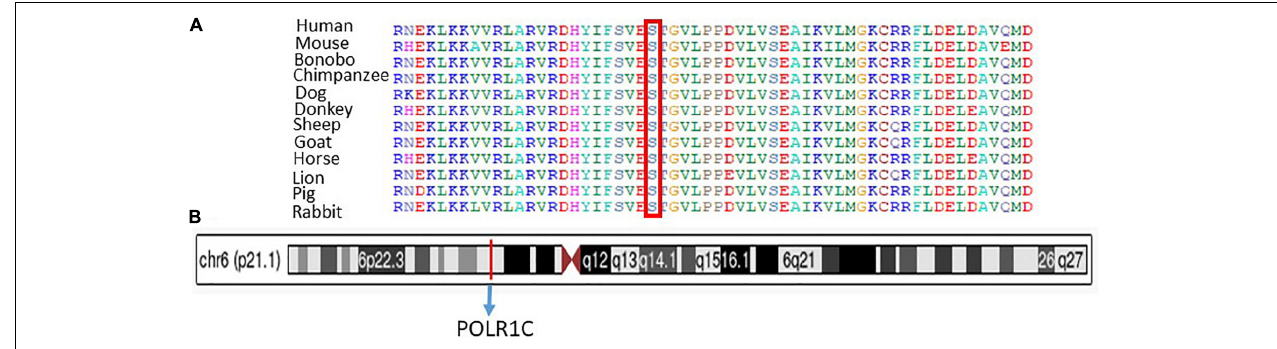
FIGURE 5 | Illustration of the wild-type and mutant structures of POLR1C and the prediction for the position of p. Ser312Pro was generated using the homology modeling platform SWISS-MODEL. (A) The 3D structure of wild-type POLR1C and (B) hydrogen bonds (blue dotted lines) of SER 312 with ASN 59, GLY 314, and LEU 316 (C) The 3D structure of mutant POLR1C and (D) PRO 312 without hydrogen bonds. The amino acid SER at position 312 in wild-type POLR1C and PRO at position 312 in the POLR1C mutant are represented as ball and stick models.